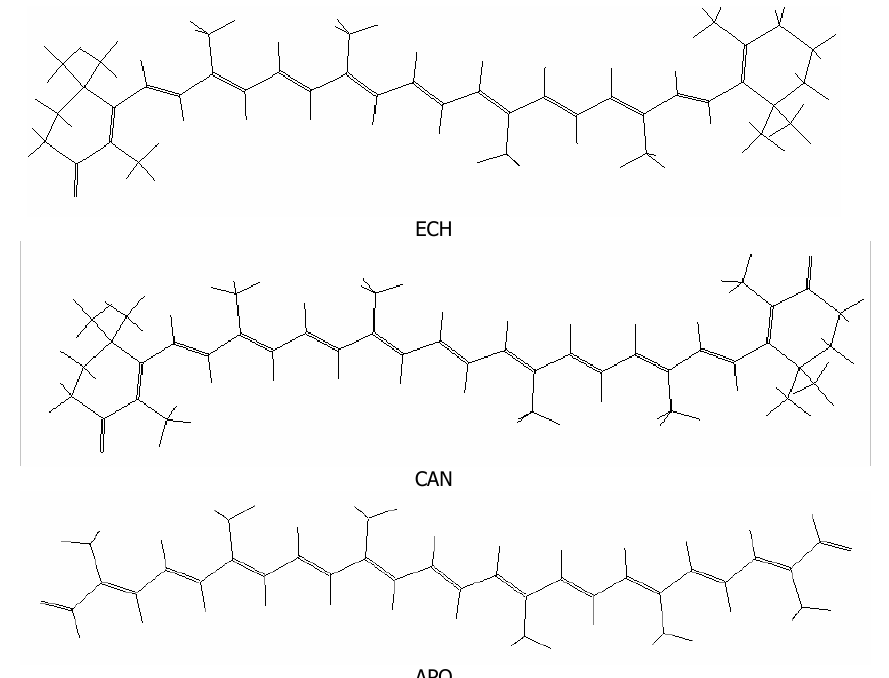
Fig. 4 Optimized geometries (PM3 calculation) for the three carotenoid